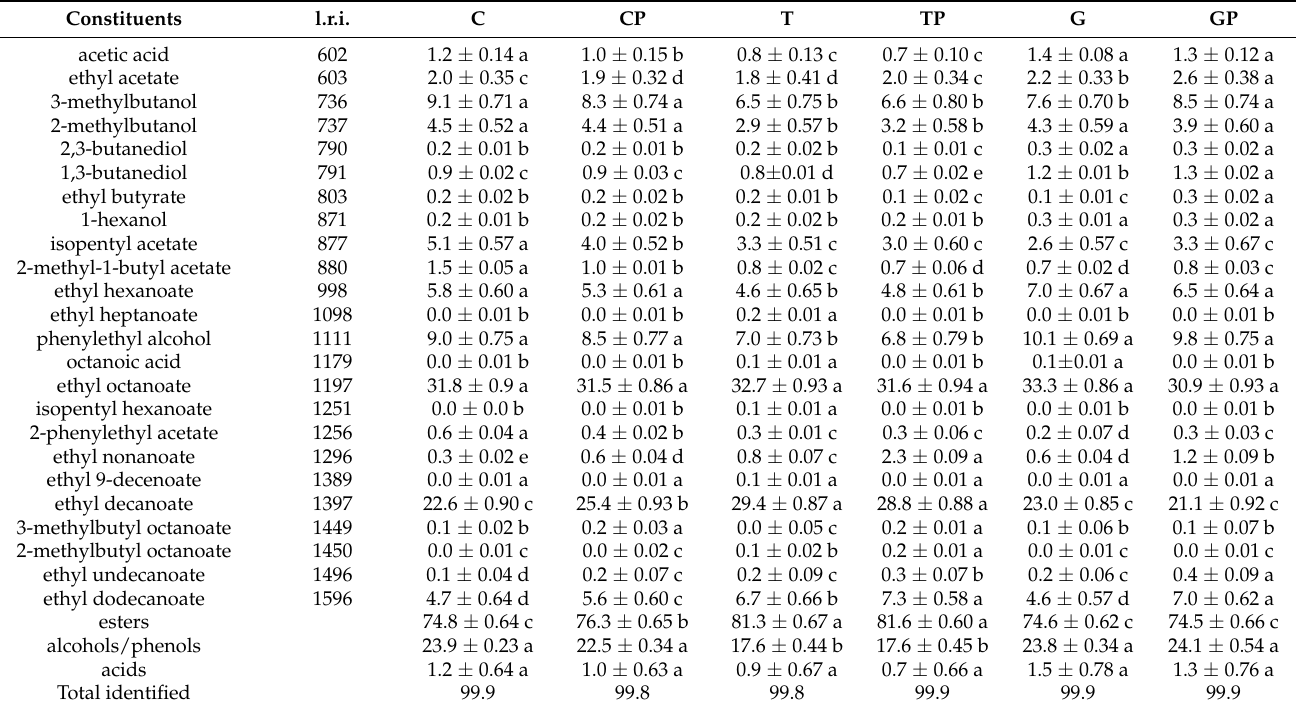
Table 10. Main classes of volatile compounds detected in wines tested at racking and their relative percentage distribution. C = Castellina, G = Gaiole, T = Tavarnelle, CP = Castellina plantarum, GP = Gaiole plantarum, and TP = Tavarnelle